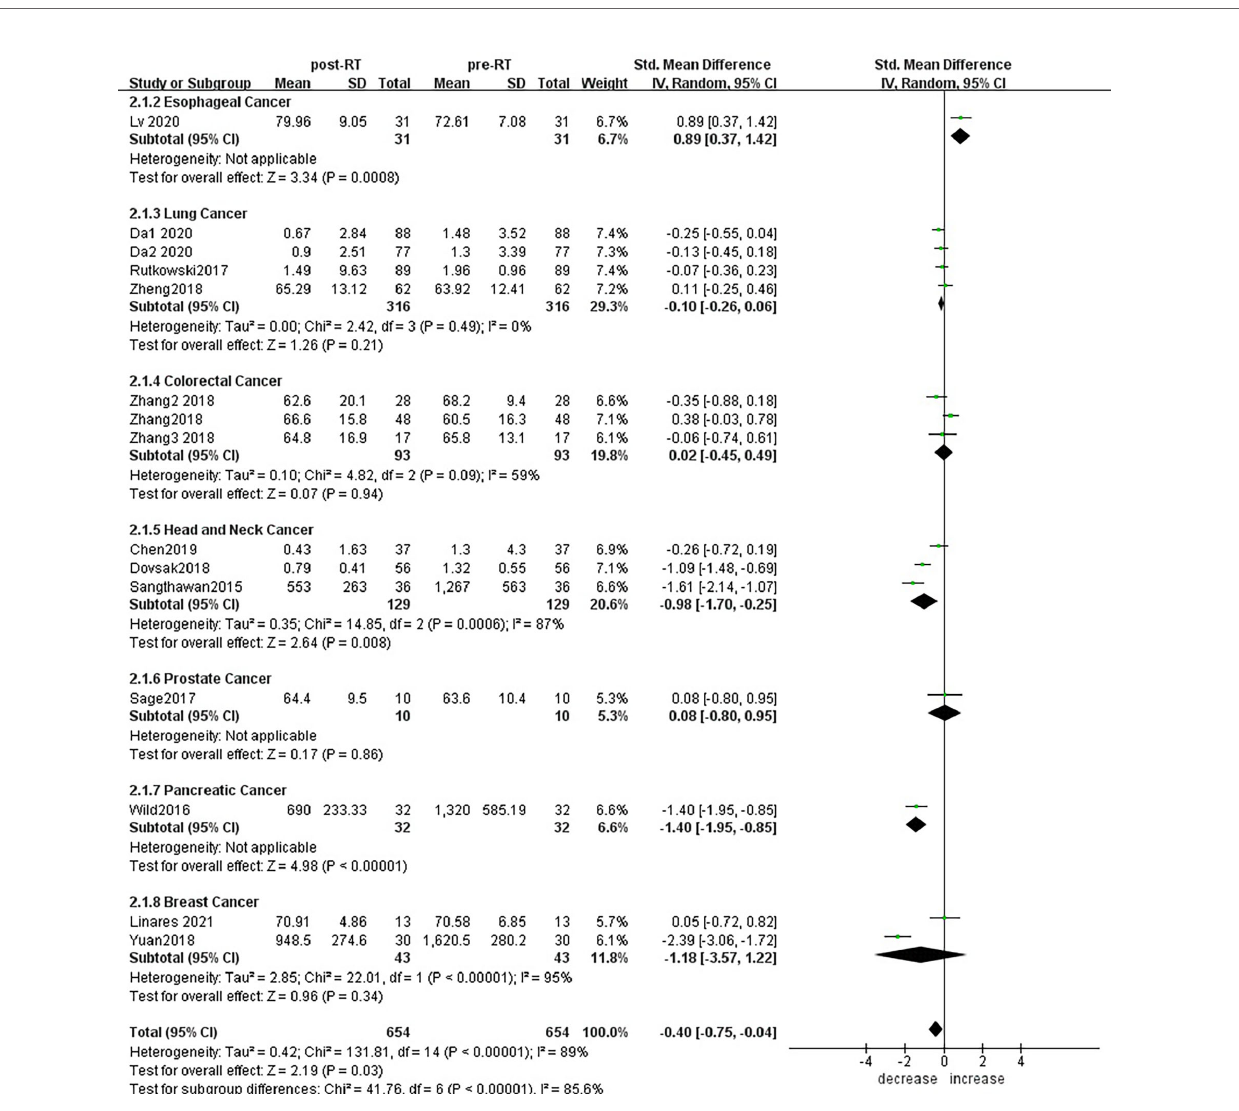
FIGURE 5 | Forest plots of subgroup analysis for changes of CD3+ T lymphocyte after radiotherapy compared with before radiotherapy in different